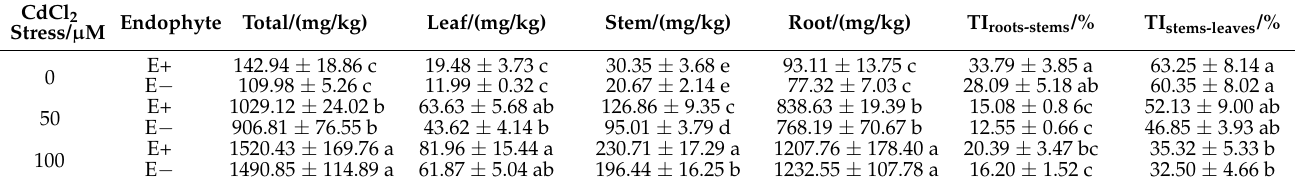
Lowercase letters indicate significant ( p < 0.05) differences between different CdCl 2 concentrations for the same